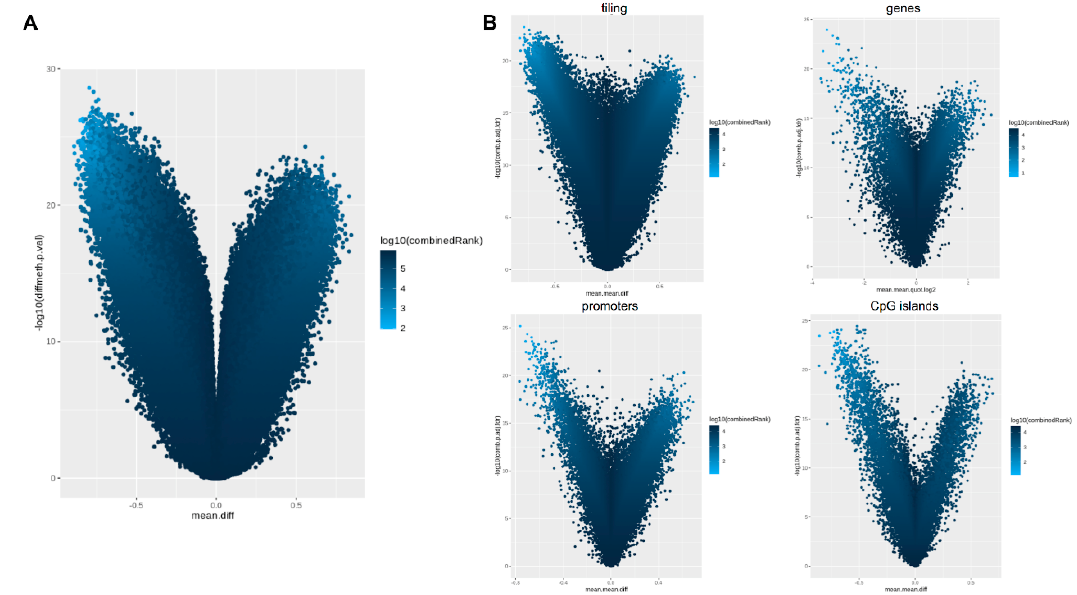
Figure 4. Methylation-profiling array: Volcano plot for differential methylation in 10 pregnancies (cases 1–10). ( A ) Volcano plot for differential methylation in CpG sites, quantified using methylation score differences between cord blood and placenta ( x -axis) and the p-value of each region ( y -axis). Points identify differentially methylated sites that are hypermethylated in placenta (left portion of the plots) or hypermethylated in cord blood (right portion of the plots). Color scale is based on a combined ranking. ( B ) Volcano plots for differential methylation in tiling, genes, promoters, and CpG islands.